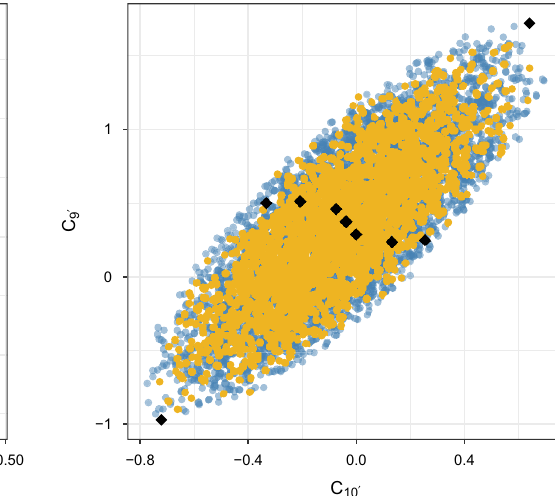
the true χ 2 distribution is not fully captured along this direction. The right plot highlights the importance of parameter correlations captured by the SVD points but not when varying one coefficient at a